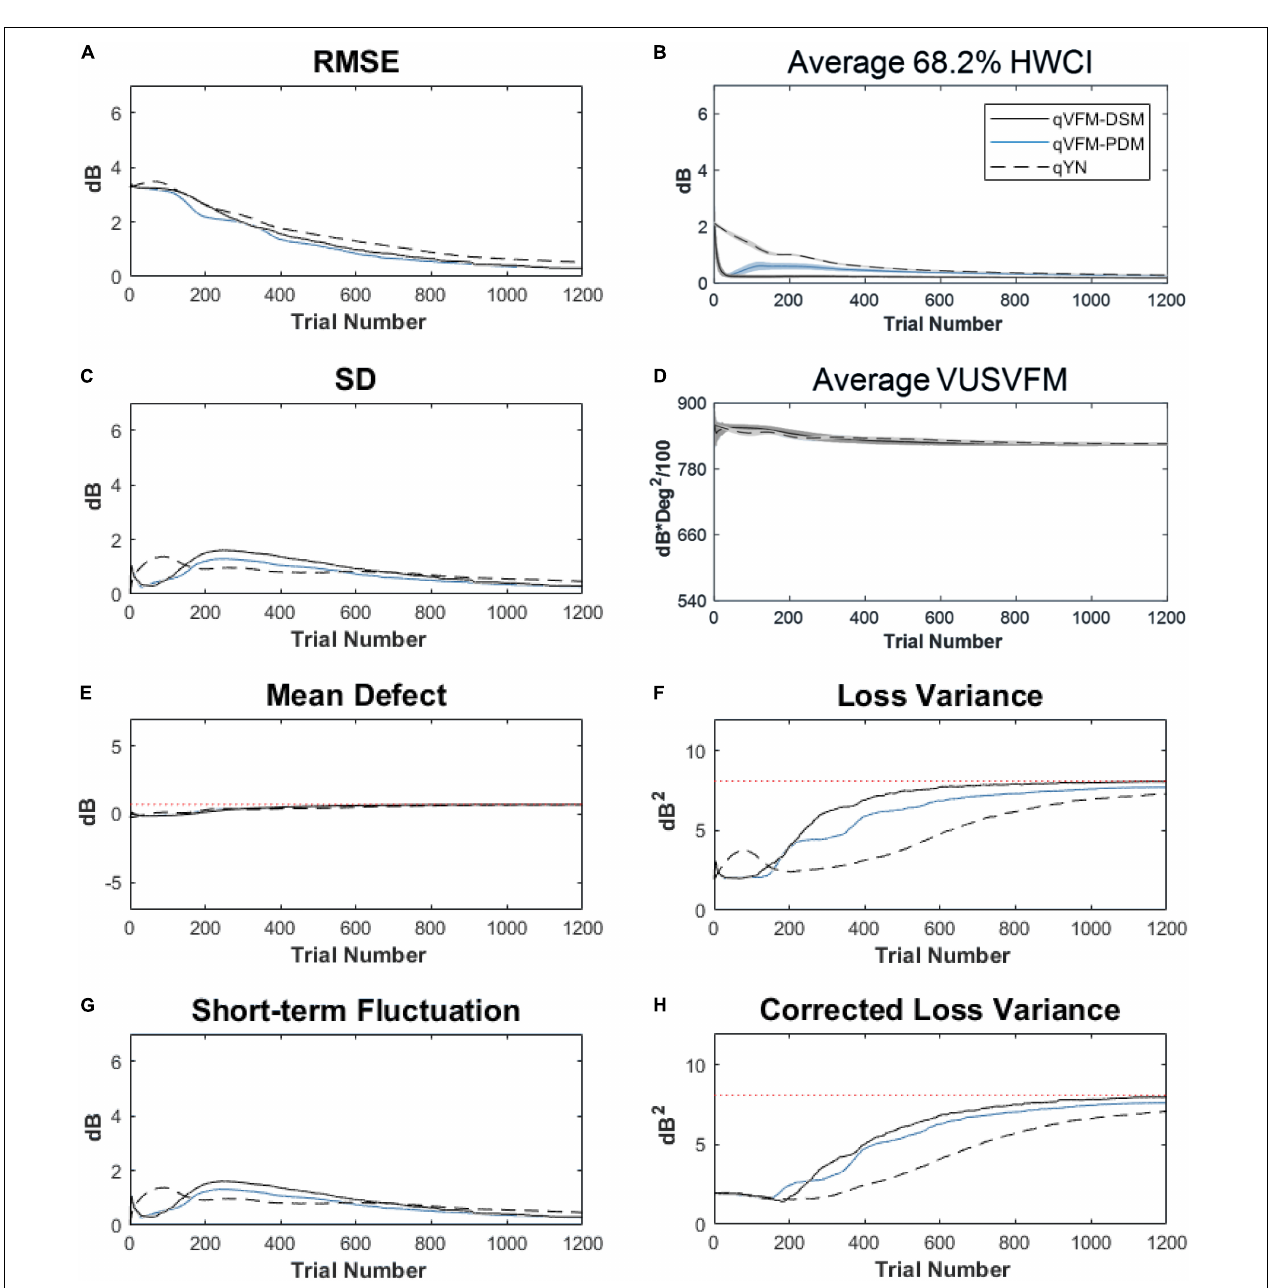
FIGURE 9 | Performance I of the three methods in estimating VFM of the simulated AMD observer across 200 runs. (A) Average root mean squared error, (B) Average 68.2% HWCI of the estimated VFM, (C) Average standard deviation, (D) Average volume under the surface of the VFM (VUSVFM), (E) Mean defect, (F) Short-term fluctuation, (G) Loss variance, and (H) Corrected loss variance. Results from the qVFM-DSM and qVFM-PDM methods are shown in solid black and blue lines, and results from the qYN method are shown in dashed lines. The true values of the global indices are shown in red dotted lines. For panels (B,D) , shaded regions represent ± 1 SD of the corresponding